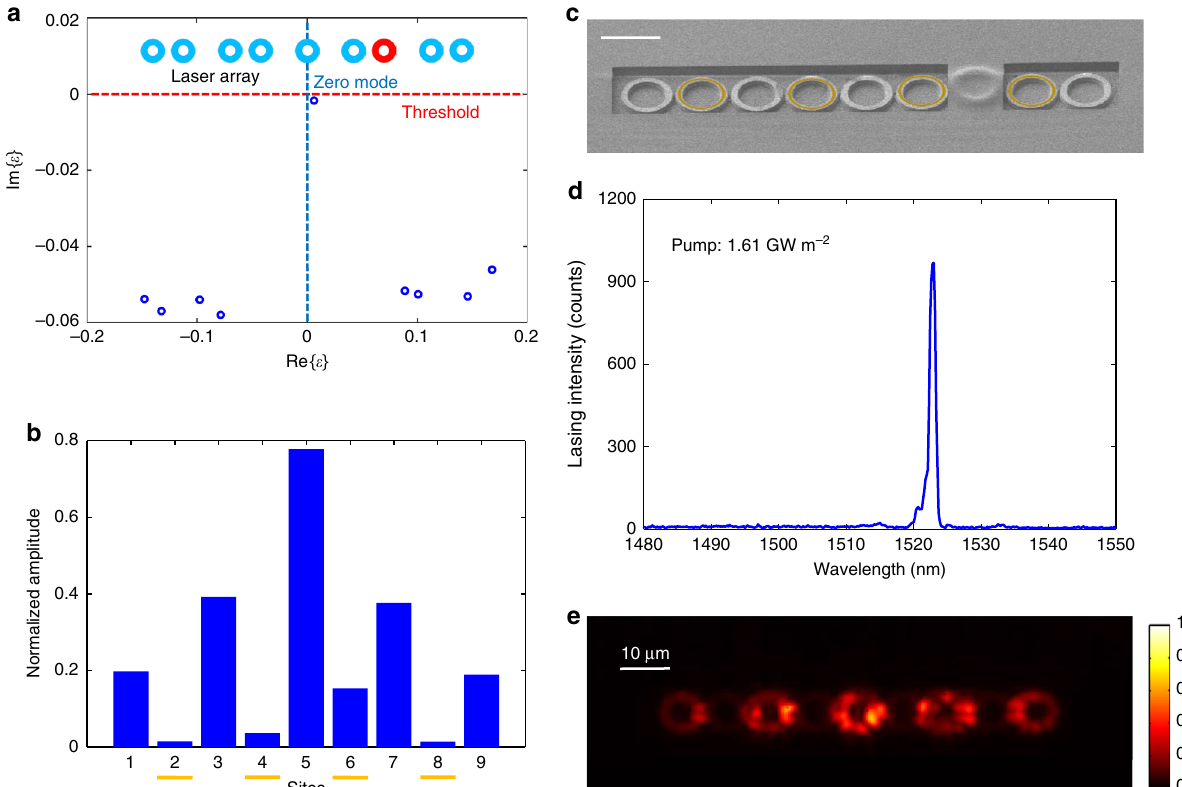
Fig. 4 Effect of disorder on the topological microlaser. a Numerical calculations for the spectrum of a disordered lattice when an onsite perturbation is introduced to the third site from the right (highlighted in red), as indicated schematically at the top of the same panel. b The mode pro fi le of the topological eigenstate, normalised with identity norm calculated from the perturbed tight-binding Hamiltonian, where the general characteristics of the zero mode persist with addition of small light intensities on the previously dark sublattice (labelled in yellow marks). c SEM image of the perturbed topological laser array with an on-top thick layer of polymer covering the corresponding ring. Scale bar: 10 µ m. d Measured emission spectrum of the perturbed laser array showing the maintained single-mode lasing feature against the introduced onsite perturbation. e Measured mode pro fi le of the perturbed laser array. Despite the introduced perturbation, single-mode lasing and its spatial pro fi le remain in the whole range of pump power (up to 2.4 GW m − 2 that is ~3 times the lasing threshold) used in our experiment. This robustness arises from the topological robustness of the defect even with nonlinearity above the threshold (see Supplementary Note